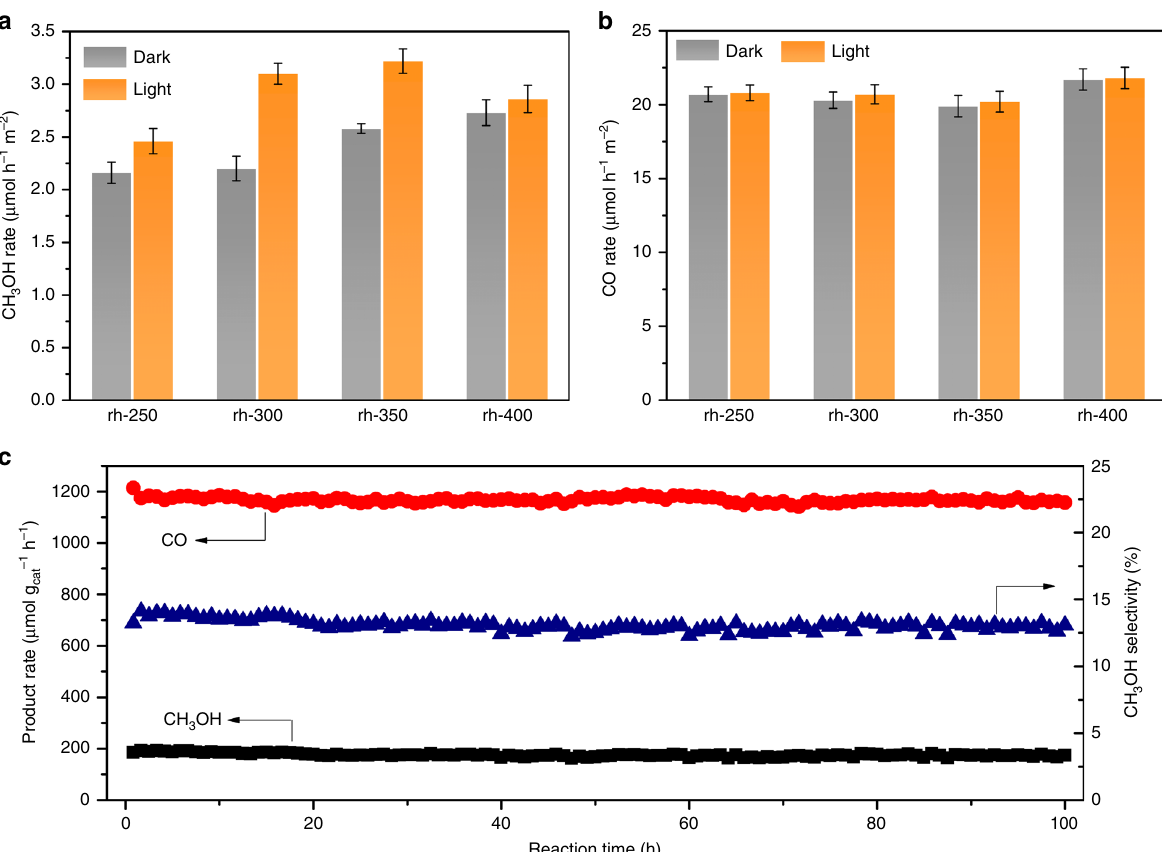
Fig. 3 Catalytic performance of various rh-In 2 O 3-x (OH) y nanocrystals. a Normalized CH 3 OH production rate at 270 °C with and without light irradiation. b Normalized CO production rate at 270 °C with and without light irradiation. c Long-term (100 h) catalytic stability of rh-In 2 O 3-x (OH) y nanocrystals (rh- 350) in catalyzing hydrogenation of CO 2 with light irradiation; reaction condition: 270 °C, 6 ml min − 1 H 2 and 2 ml min − 1 CO